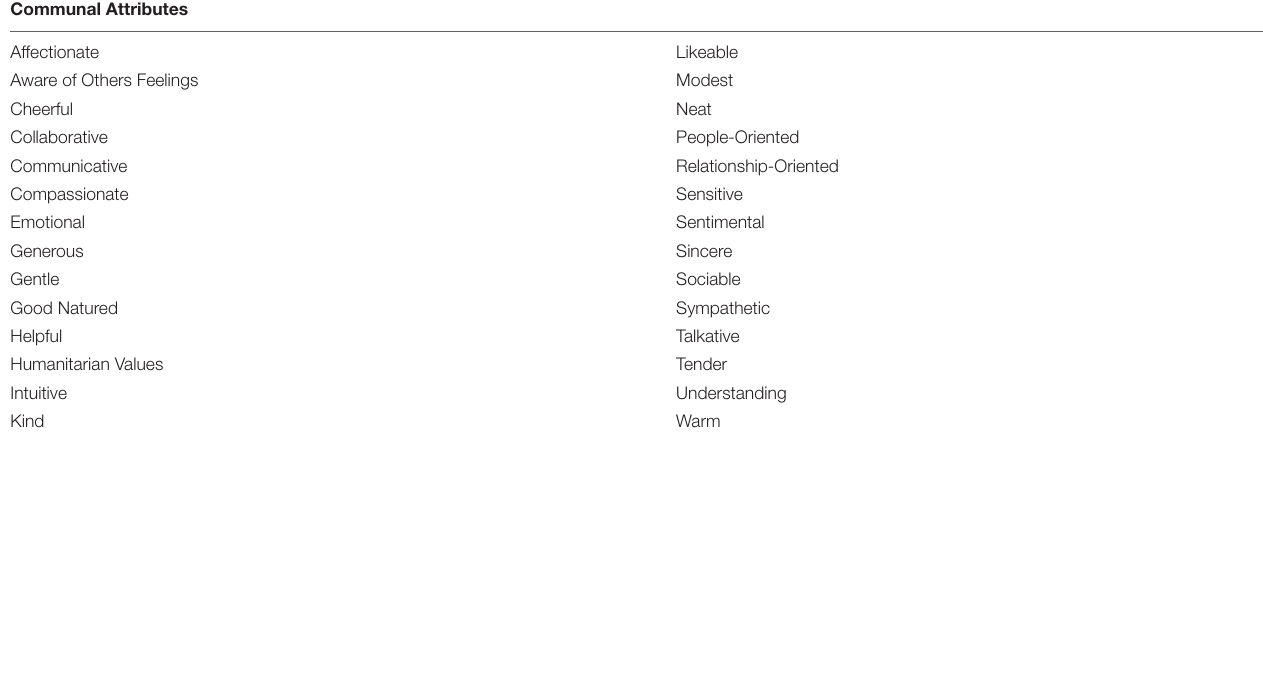
TABLE B | List of communal attributes